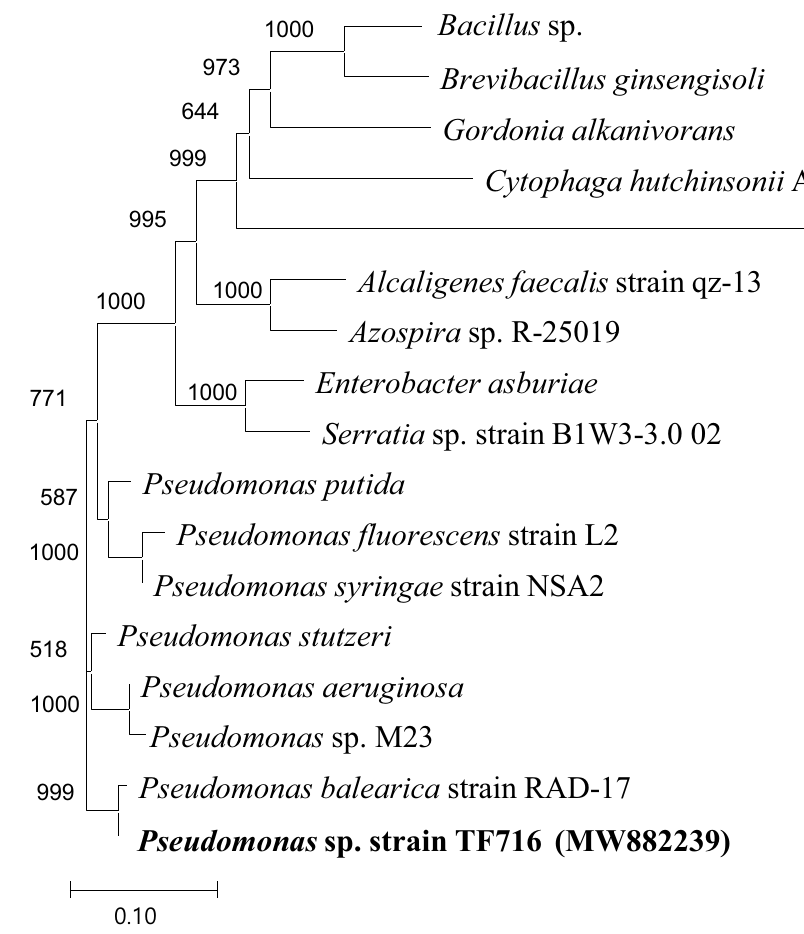
Figure 1. Phylogenetic relationships between Pseudomonas sp. TF716 and known N 2 O-reducing bacteria. A neighbor-joining algorithm was used to construct the tree. The scale bar represents 0.1 expected substitutions per